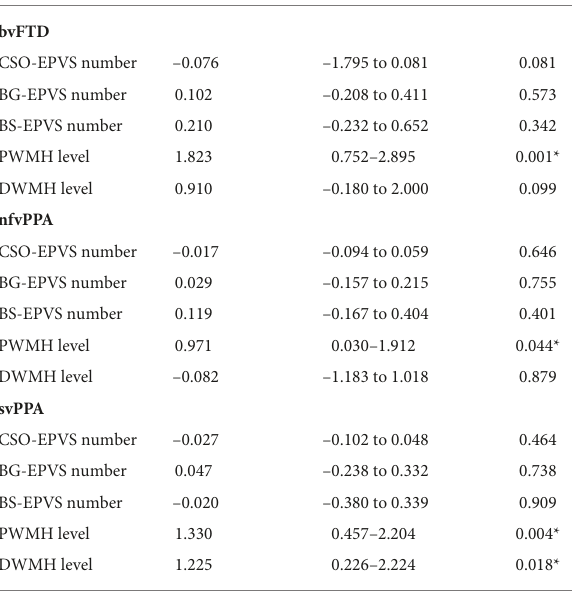
TABLE 4 Association of EPVS and WMH with FTLD-CDR scores in bvFTD, nfvPPA, and svPPA. β Estimate Confidence interval (95%) p